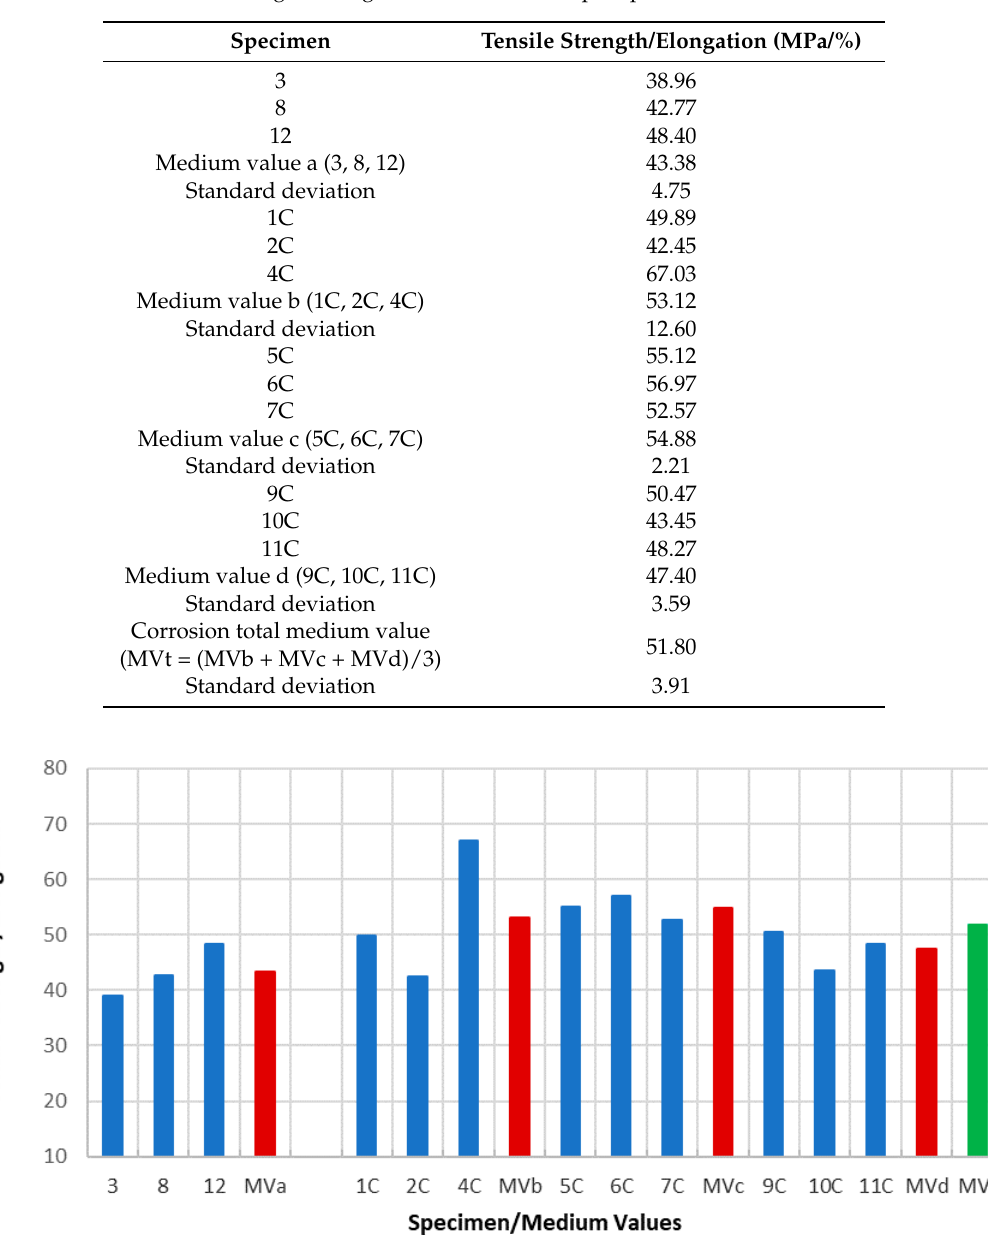
Table 7. Tensile strength/elongation relation values per specimen and medium values.